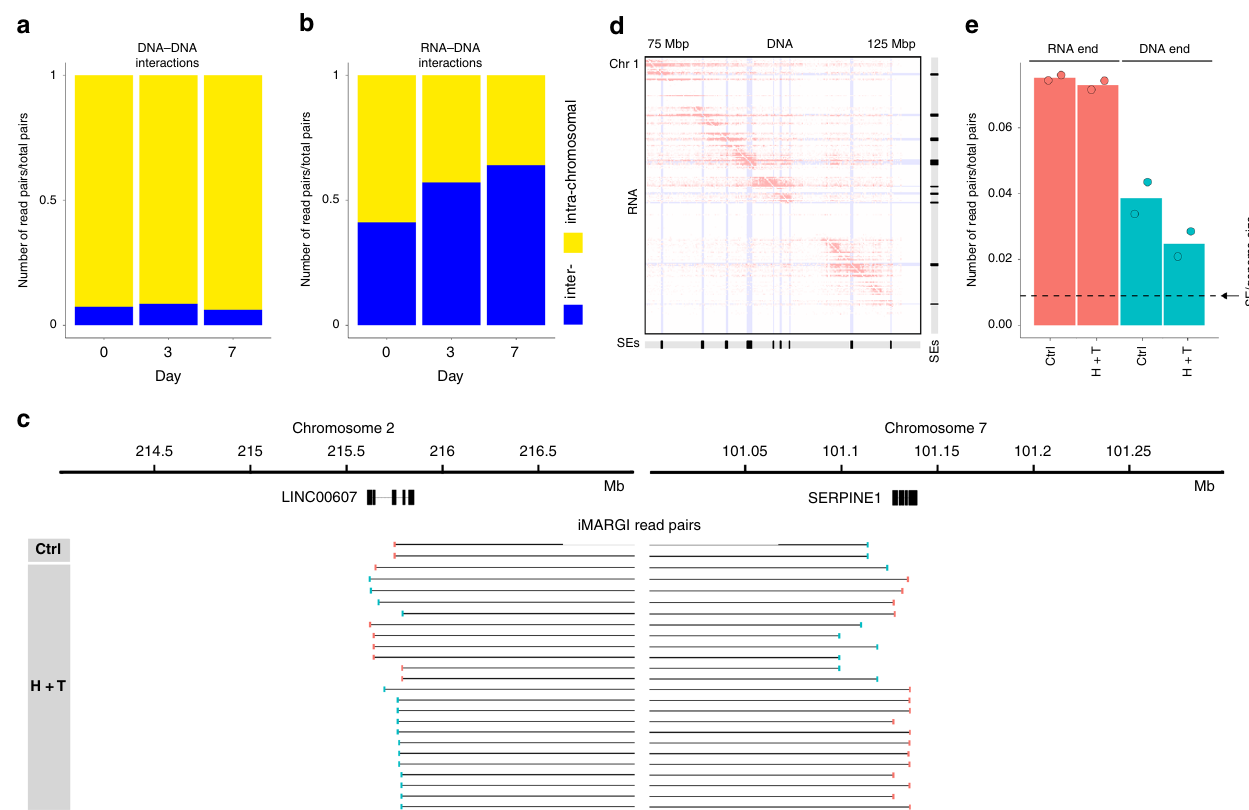
Fig. 2 Overview of time-course Hi-C and iMARGI data. a , b Proportions of intrachromosomal (yellow) and interchromosomal read pairs (blue) in Hi-C ( a ) and iMARGI data ( b ) at the three time points (columns). c An example of interchromosomal iMARGI read pairs mapped to chromosome 2 near LINC00607 (left) and chromosome 7 near SERPINE1 (right). The RNA end (pink) and the DNA end (green) of each read pair is linked by a horizontal line. d Examples of overlapping iMARGI read pairs on a contact matrix from the RNA end (rows) to the DNA end (columns) with SEs (marked in light blue and in SE tracks) in control (Day 0) ECs. Genome region: chr1:75,000,0000 – chr1:125,000,000. Resolution = 200 kb. e Proportions of iMARGI read pairs with the RNA ends (pink) or the DNA ends (green) in Day 0 (Ctrl) and Days 3 and 7 (H + T) ECs mapped to HUVEC SEs. Dotted line: the relative size of HUVEC SEs compared to the size of the genome. Source data are provided as a Source data fi